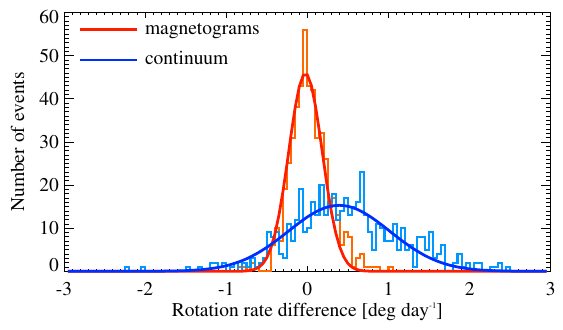
Figure 4. The distributions of the differences between the theo- retical rotation rate (derived from magnetic field data) and the measured rotation rates derived from magnetic field (orange) and continuum intensity (light blue) data (see text). Red and blue curves represent the fittings of the distributions by a Gaussian. A slight asymmetry of the distributions is clearly